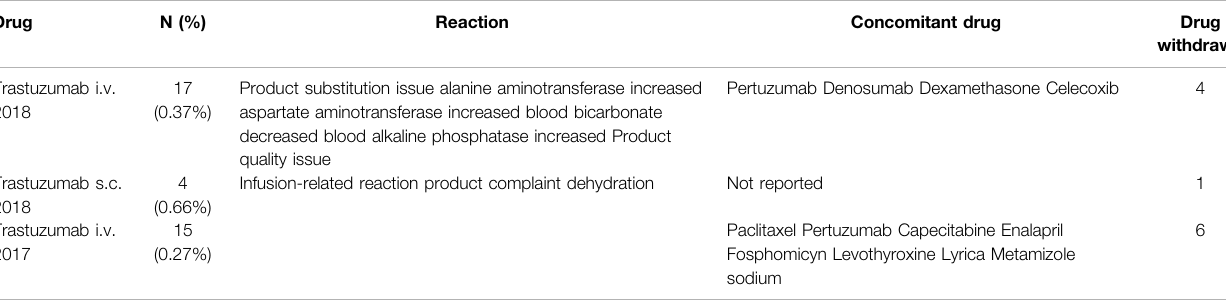
TABLE 5 | Cases of “ Product Issues ” of the intravenous and subcutaneous trastuzumab (2015 – 20). Drug N (%)